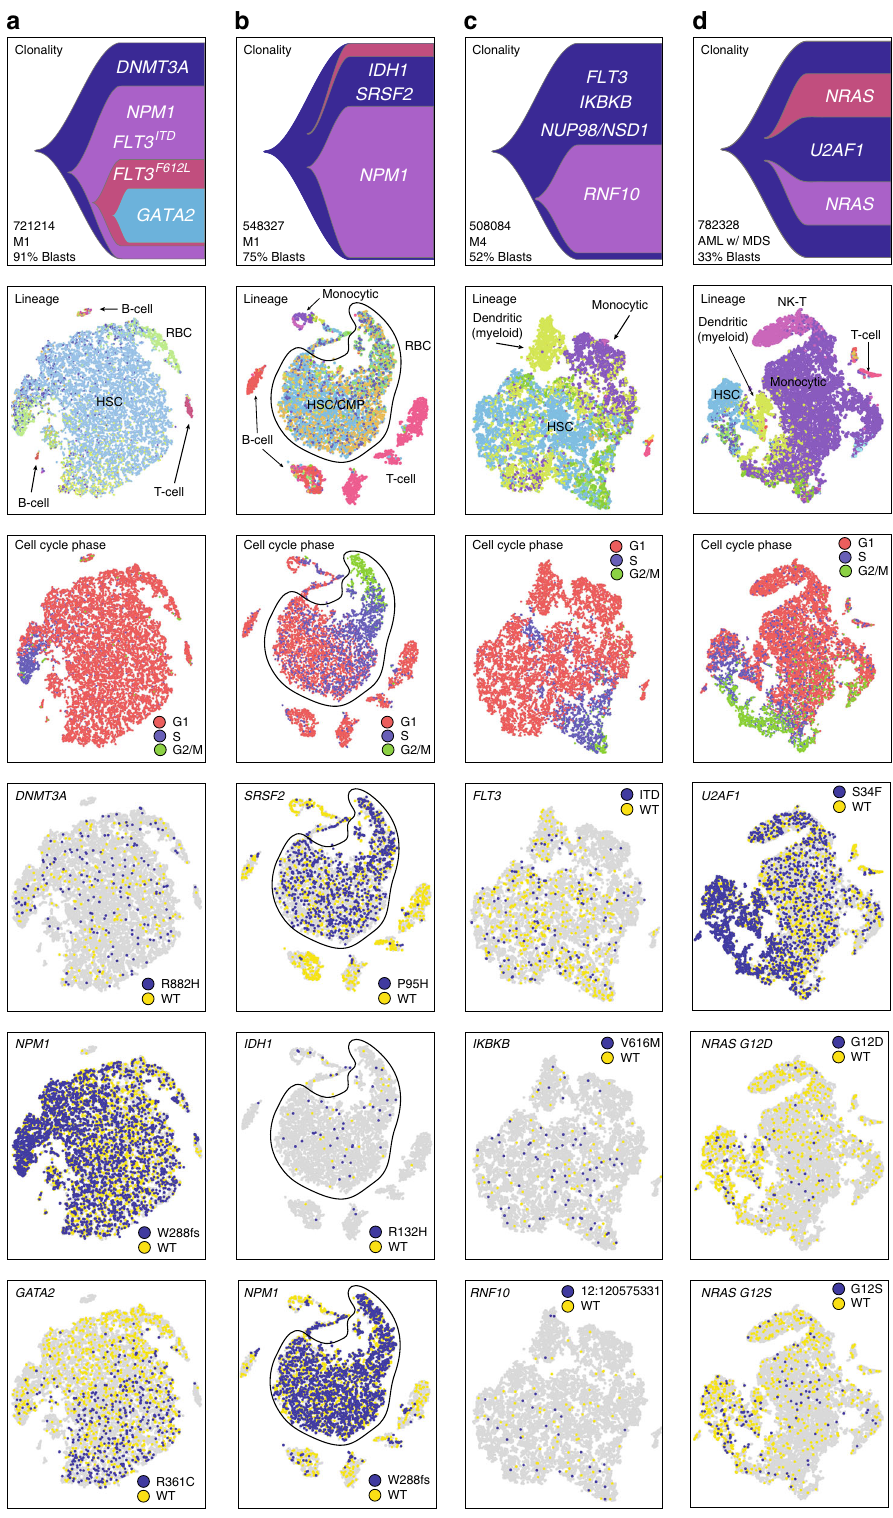
Fig. 4 Single-cell mutation detection and interpretation in additional cases ordered by the differentiation signature of AML cells. a 721214, top to bottom: clonality inferred from eWGS; cells colored according to closest inferred lineage (RBC = red blood cell, HSC = hematopoietic stem cell, CMP = common myeloid progenitor); cells colored according to cell cycle phase; cells colored according to single-cell genotype at the indicated site: blue, at least one mutant read detected; yellow, wild-type reads only; gray, no coverage. b 548327, putative AML cells circled. c 508084. d